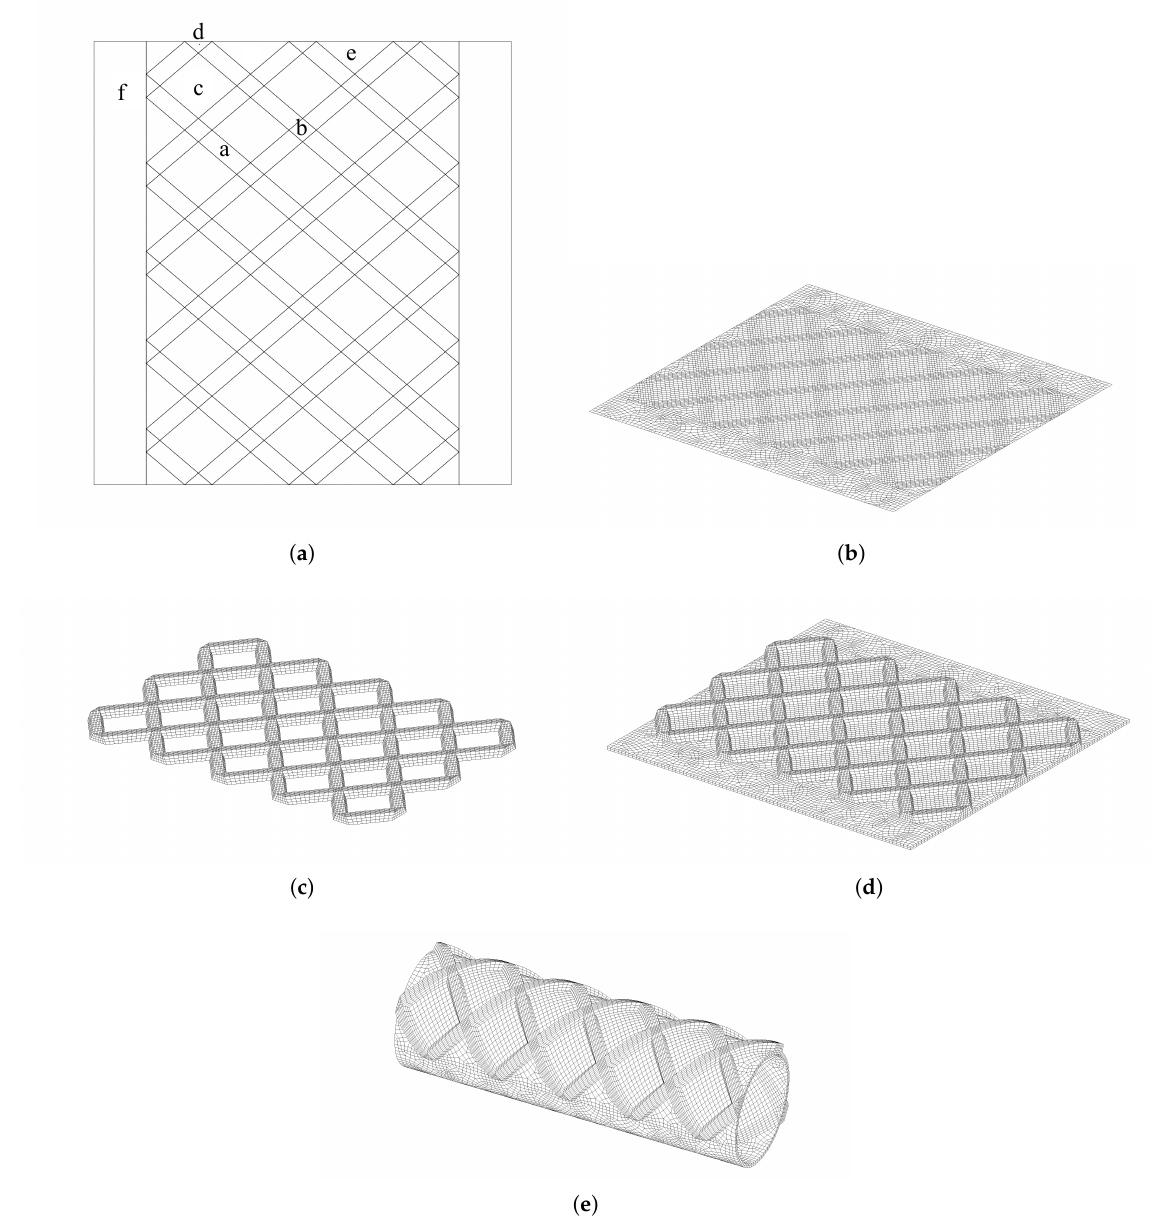
Figure 5. Generation of the prosthesis using the in-house code. ( a ) Planar geometry: generated surfaces a, b, c, d e, f; ( b ) Planar mesh; ( c ) Fiber extrusion; ( d ) Planar 3D mesh; ( e ) Final 3D mesh of the